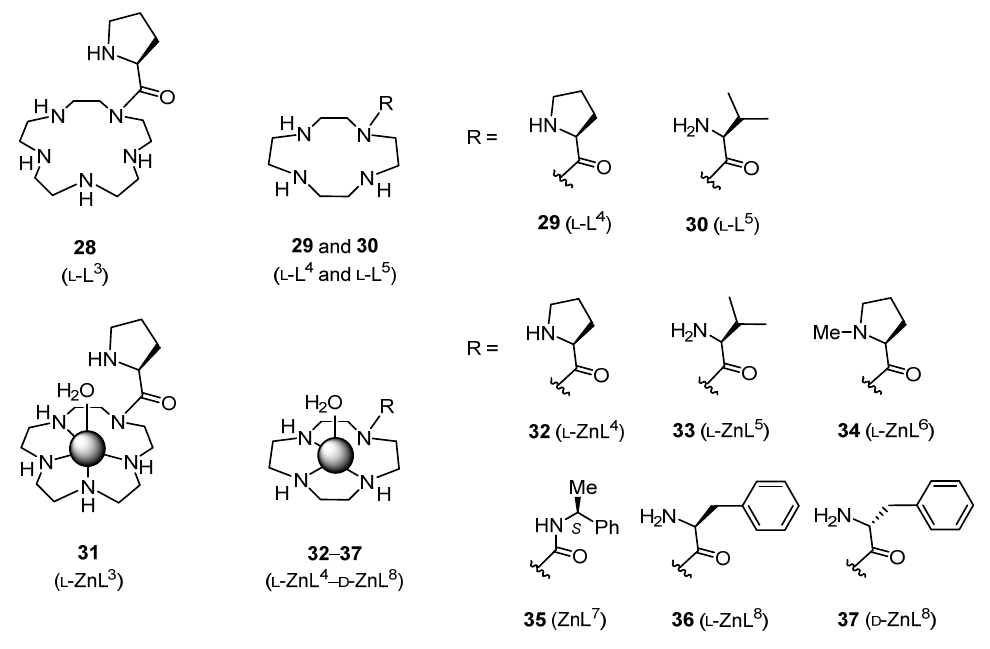
Figure 1. Zn 2+ complexes for direct asymmetric aldol